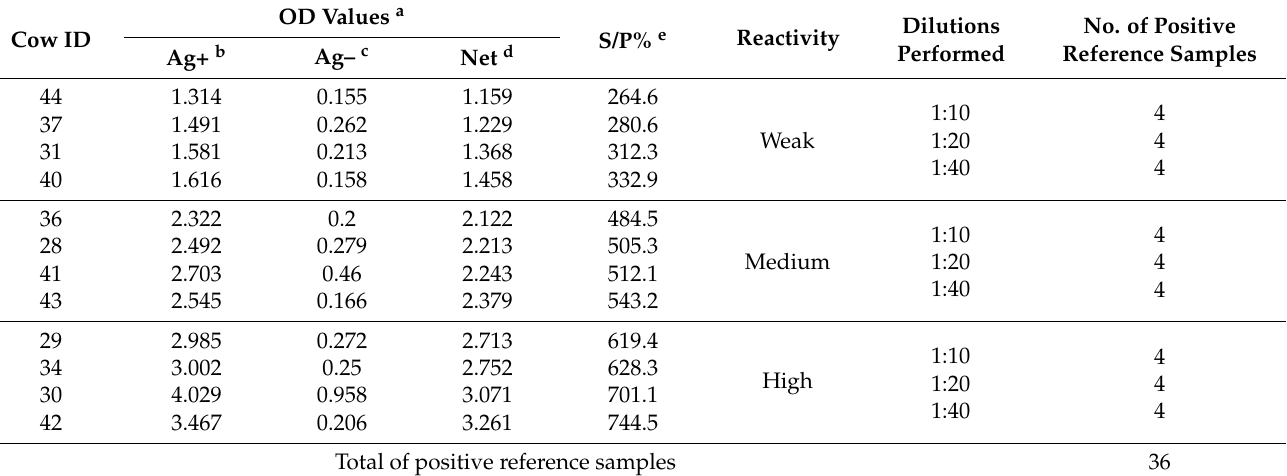
Table 3. Positive individual milk samples tested with ERADIKIT™ BMSK PLUS and diluted respec- tively at 1:10, 1:20, and 1:40 to obtain the set of positive reference